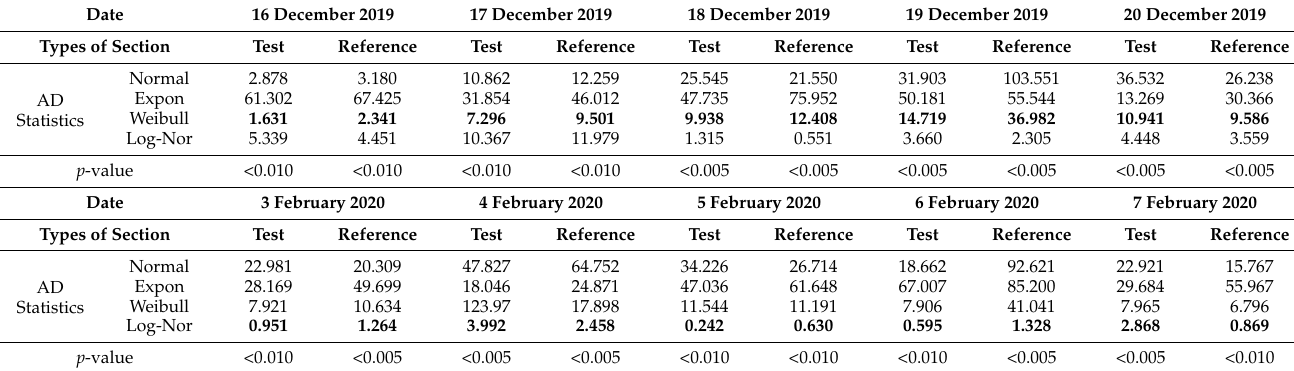
Table 3. Results of Anderson-Darling Test in the Test and Reference